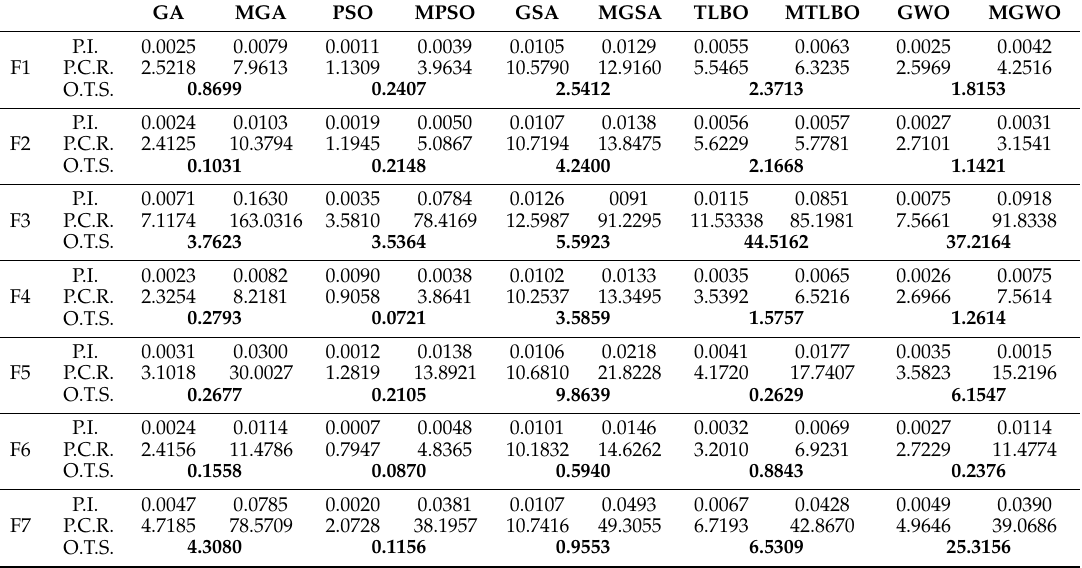
Table 7. Computational time analysis on unimodal objective functions (second).